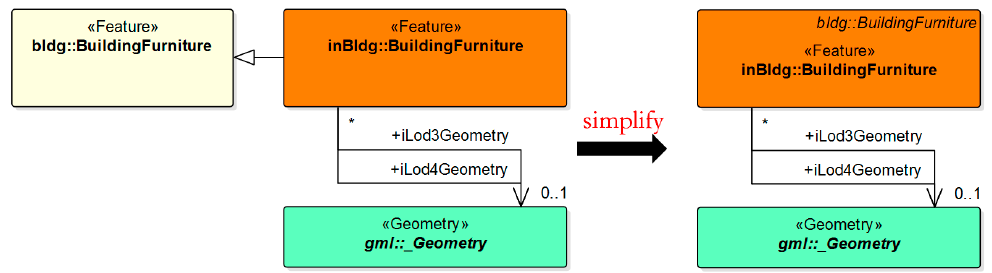
Figure 8. The subclass BuildingFurniture in application domain extension (ADE) that contains additional properties compared to the equivalent CityGML class, and its simplified version.